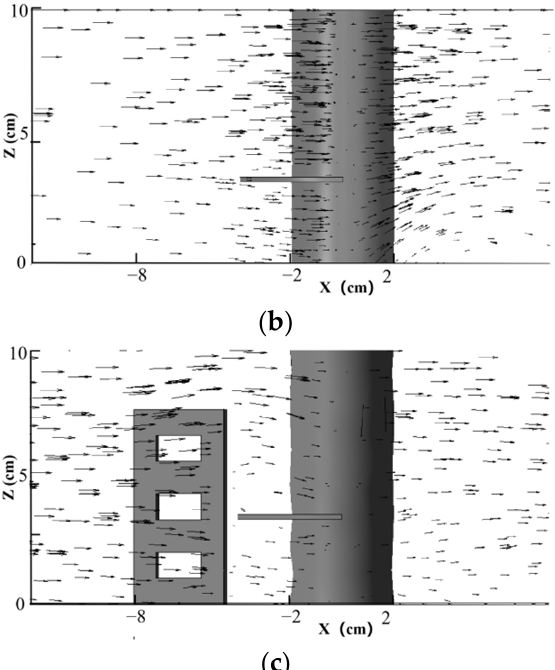
Figure 15. Velocity vectors at Y = − 2 cm. ( a ) Single pier; ( b ) Pier with ring-wing plate; ( c ) Pier with combined device.